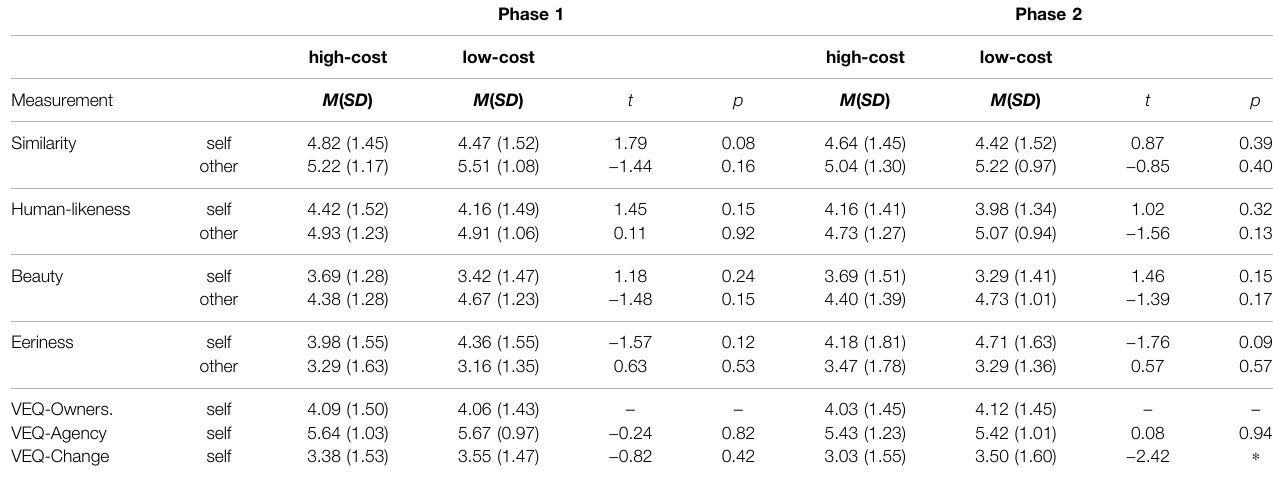
TABLE 2 | Means, standard deviations, and test statistics for the paired samples t-tests for the perception of the virtual humans. For all t-tests: df (cid:2) 44. p < .05